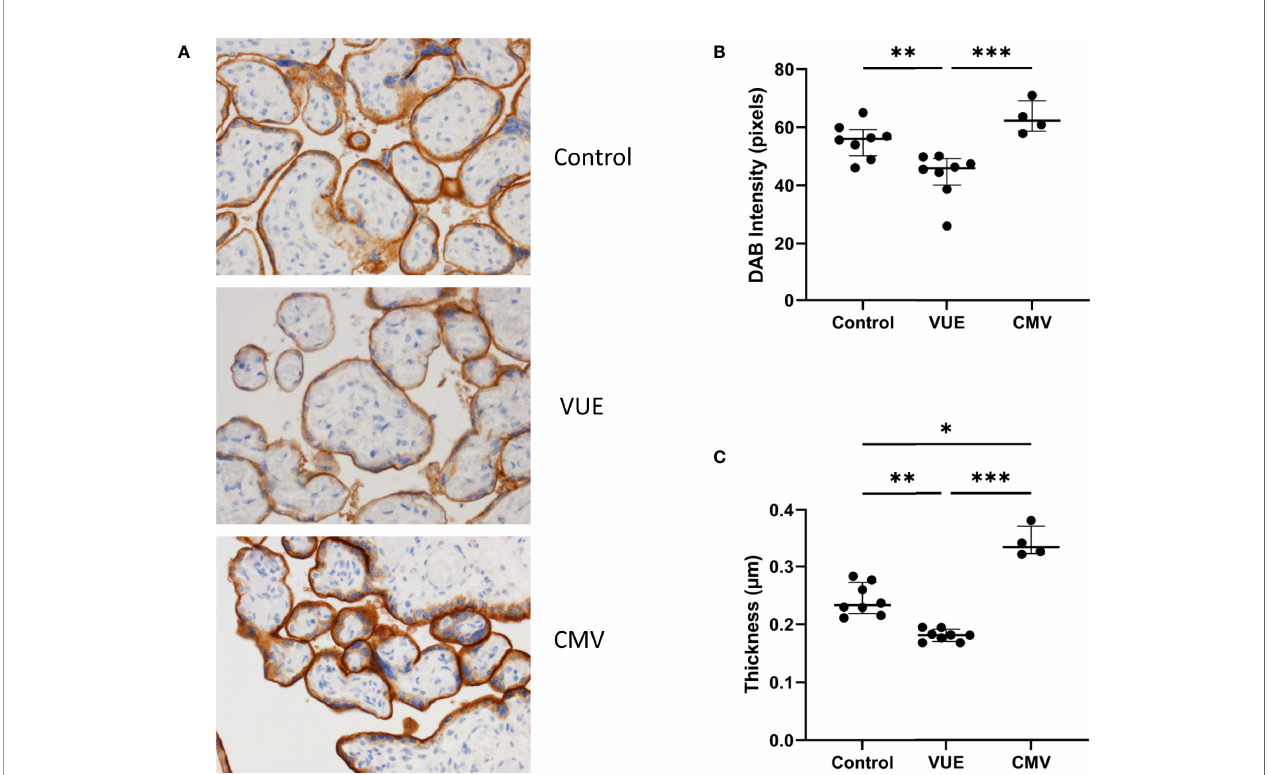
FIGURE 1 | PD-L1 expression in placentae with infectious and non-infectious diagnoses. (A) Representative PD-L1 staining in all three groups (200X). (B) Average intensity of DAB staining between control, VUE and CMV groups. (C) Mean PD-L1 membrane thickness between groups. Graphs show median with interquartile ranges. Data was compared by Kruskal-Wallis testing with post hoc analysis using the false discovery rate method of Benjamini, Krieger and Yekutieli (n=4-8/group). *p ≤ 0.05; **p ≤ 0.01; ***p ≤